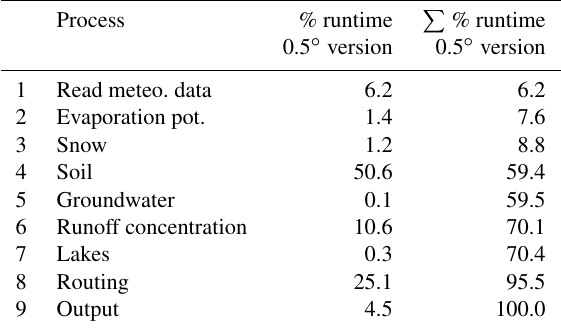
Table 3. Computational time for a 0.5 ◦ global run in sequence of hydrological process (rain to river) and module setup.